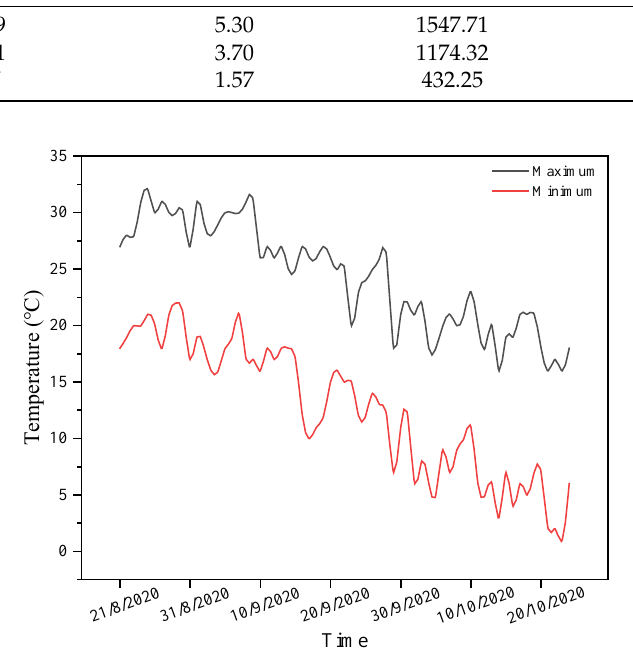
Figure 1. Changes in temperature during the experiment.